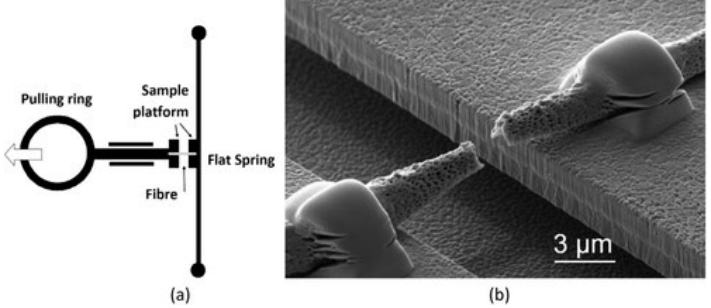
Figure 14. ( a ) MEMS-based tensile testing setup, and ( b ) SEM image of single nanofiber after tensile test. Reprinted from [123] with permission from John Wiley and Sons.